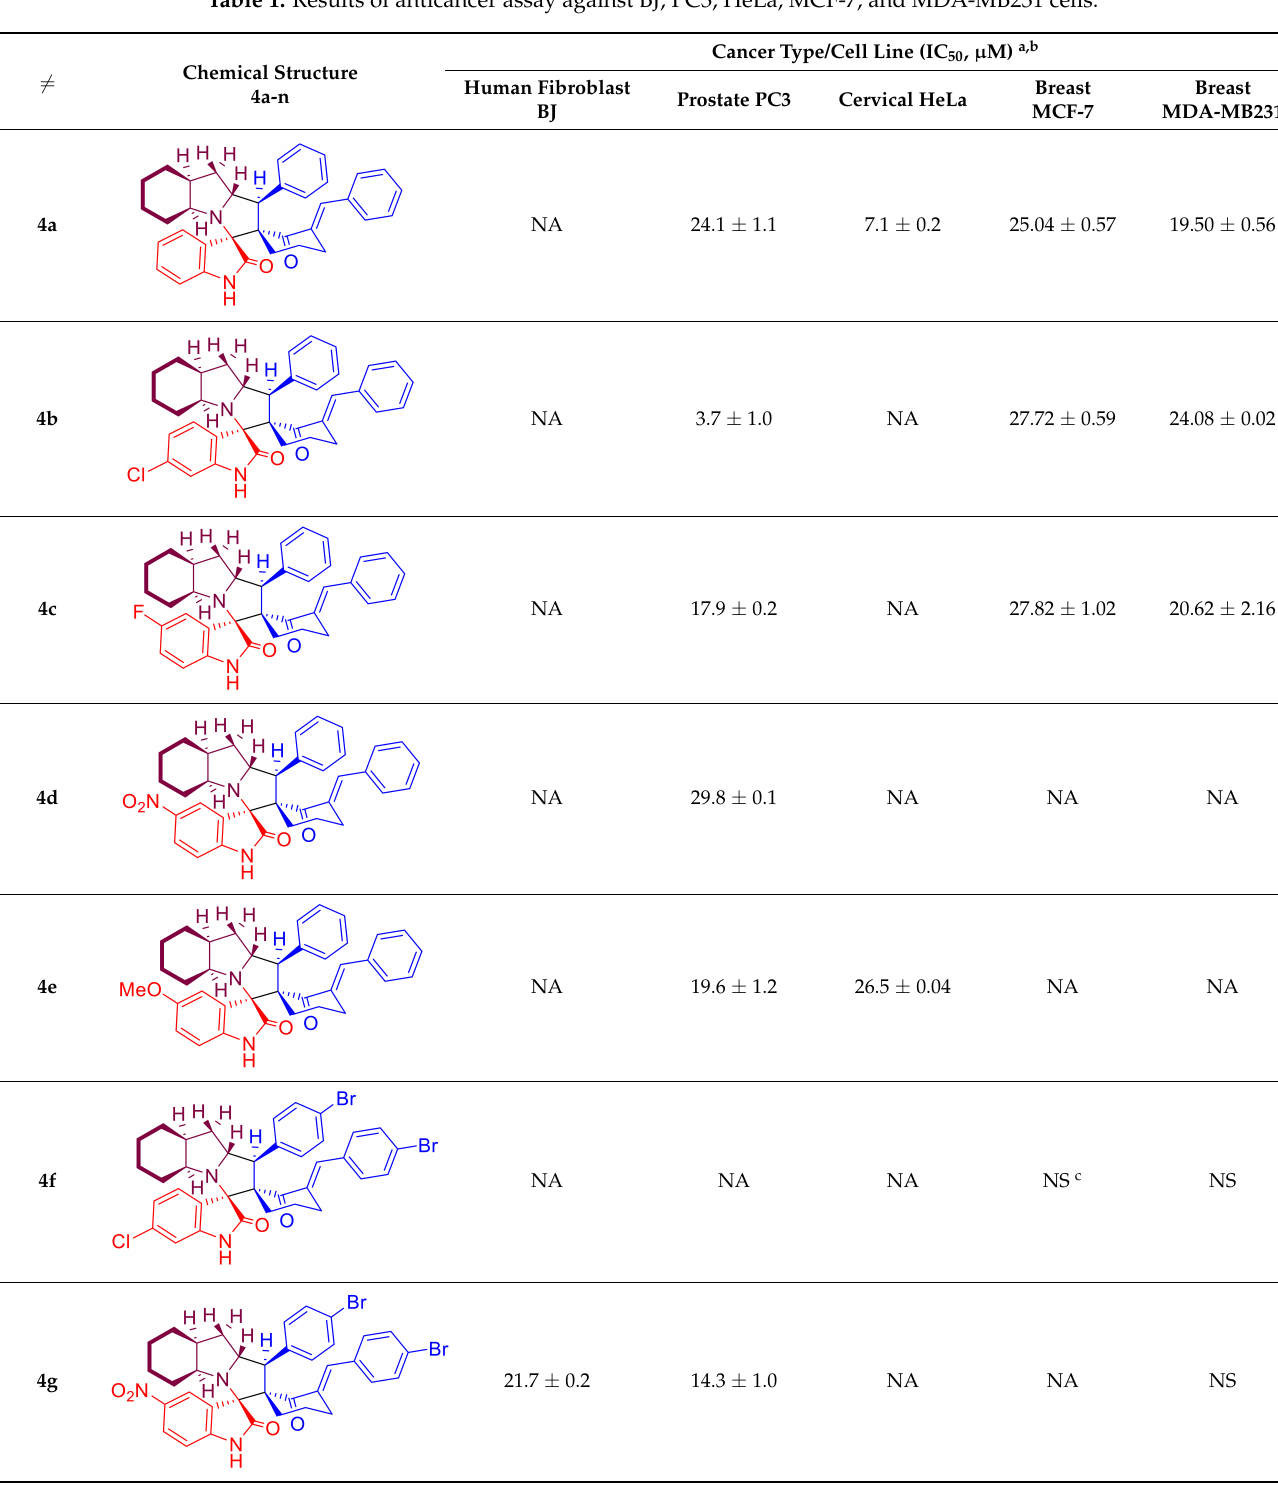
Table 1. Results of anticancer assay against BJ, PC3, HeLa, MCF-7, and MDA-MB231